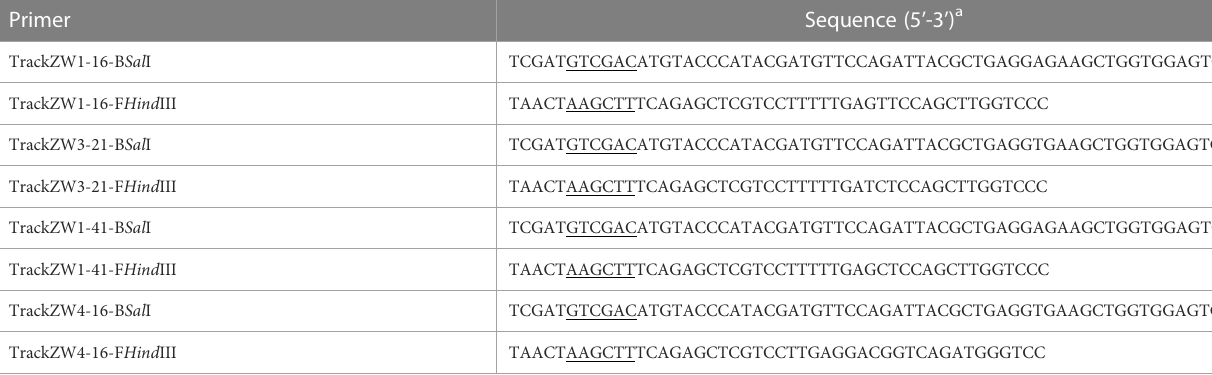
TABLE 1 Primers used to amplify four scFvs for recombinant adenovirus vector construction.